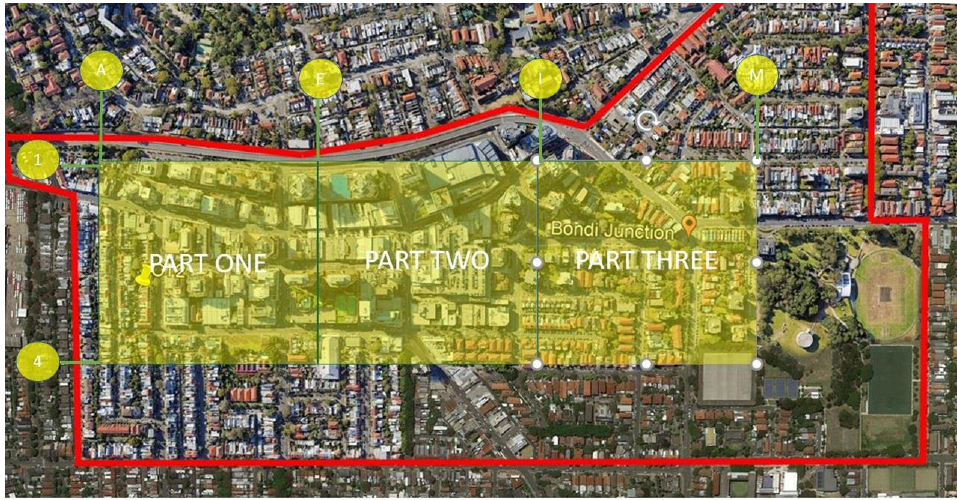
Figure 2. The study area located in Bondi Junction is represented by three main